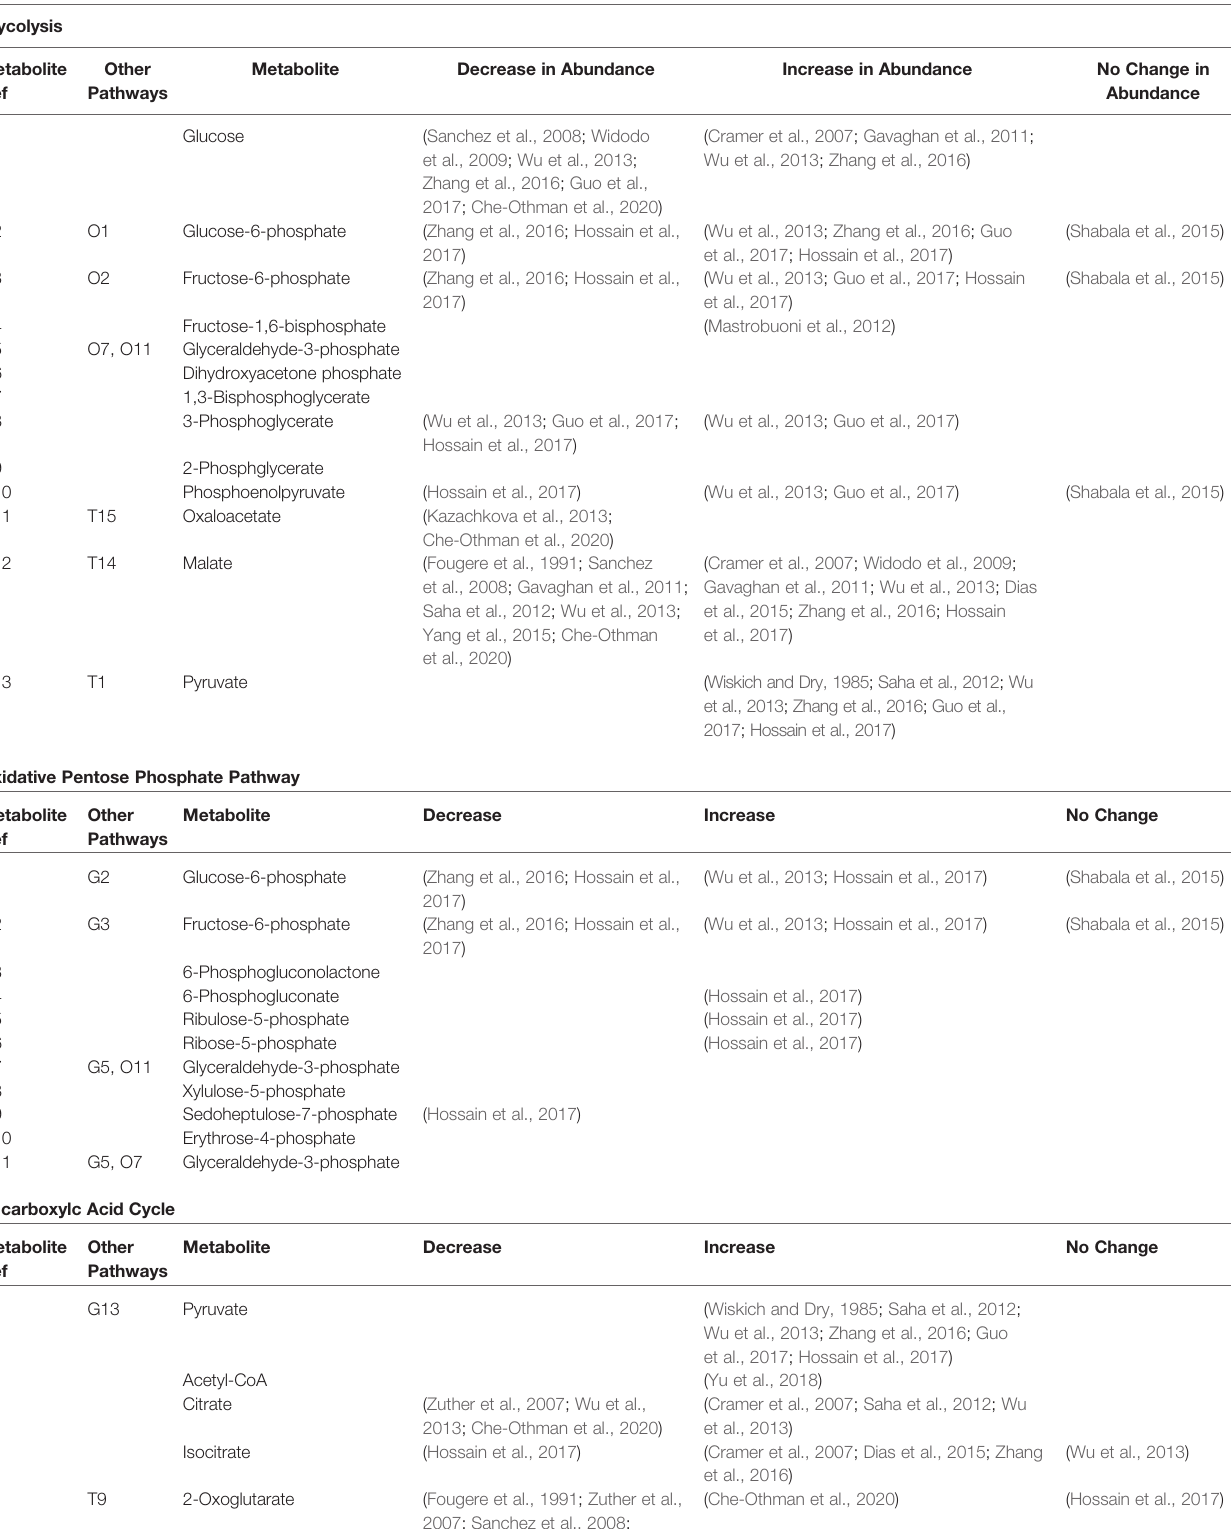
TABLE 1 | Research observations of changes in independent and shared metabolite abundances involved in glycolysis, the oxidative pentose pathway, and the TCA cycle during salinity